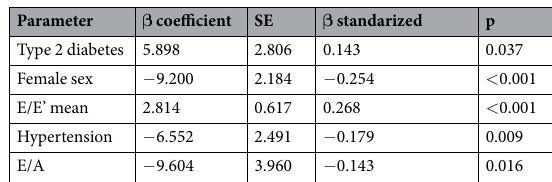
Table 4. Multivariable analysis of baseline characteristics and echocardiographic parameters associated with left ventricular mass index. LVMI-left ventricular mass index, E/A-ratio of early to late mitral valve flow velocity, E/E ′ -ratio of early mitral valve flow velocity to early Tissue Doppler lengthening